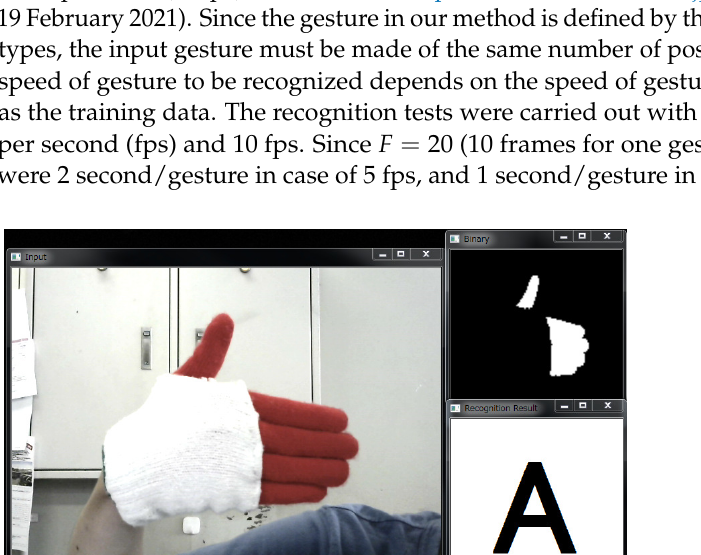
Table 2. Confusion table (5